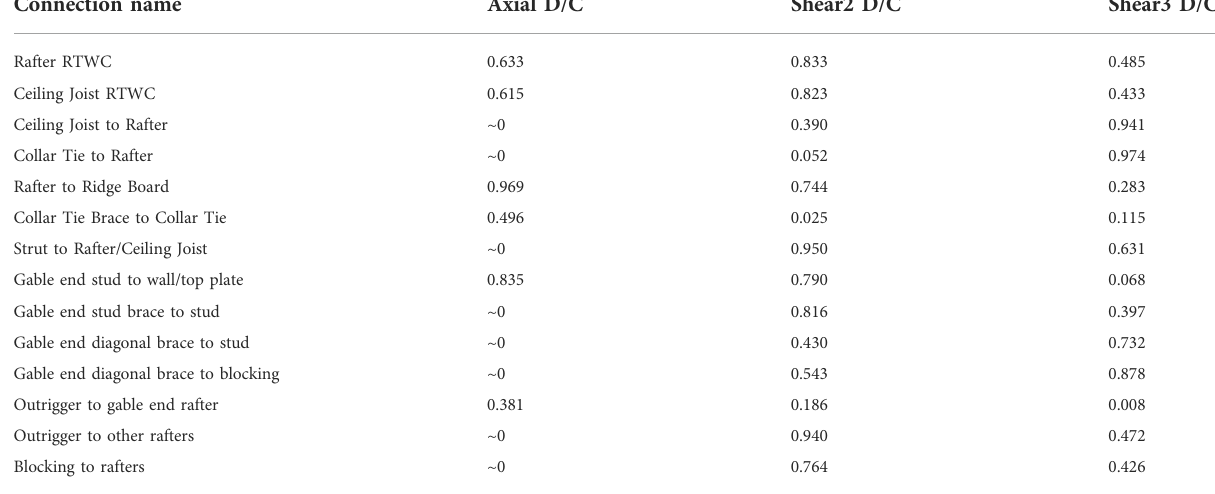
TABLE 7 Final D/C ratios of the